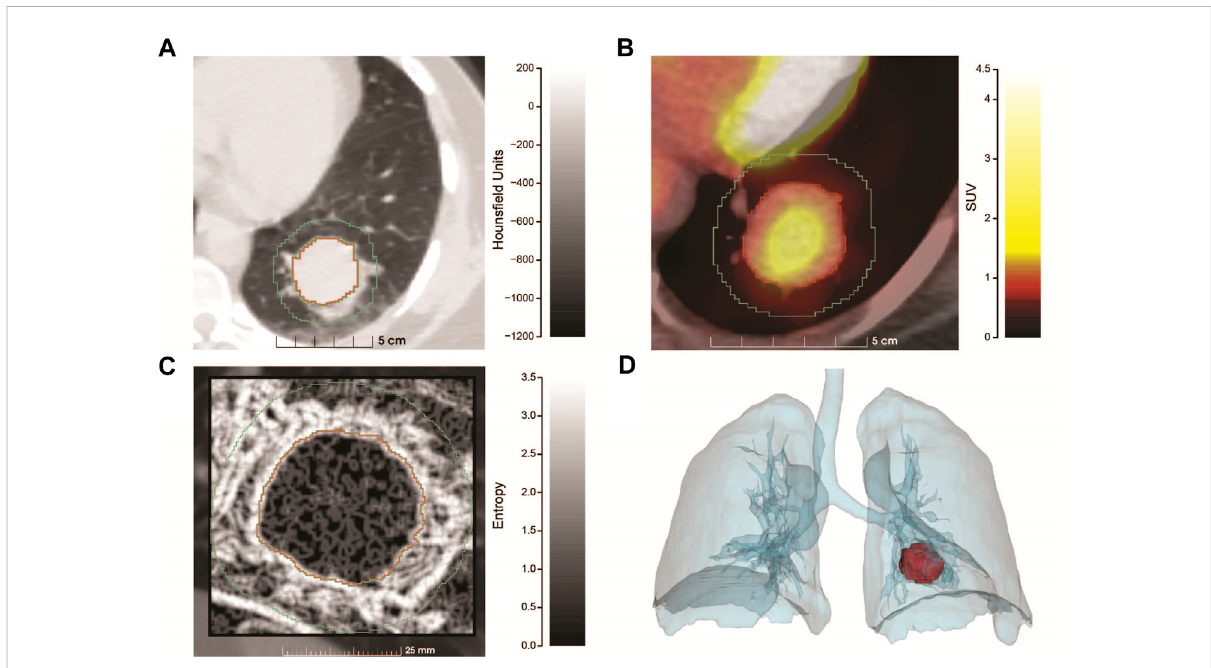
FIGURE 1 Radiomics analysis of the PSP tumor. (A) Pre-operative chest CT scan with contrast utilizing lung window settings. The image is an axial projection that has been zoomed to show an optimal view of the tumor that resides in the left lower lung along with a small region of the mediastinum. Tumor segmentation is outlined in red, with the 1 cm border surrounding the tumor proper, outlined in green. The x-axis contains a sizescale(cm)andy-axisHouns fi eldUnits(HU)scale( − 1200 – 200)withshading. (B) CombinedPET/CTofthetumor(zoomed)atdiagnosis.The tumorhadaSUVmaxof2.2andSUVmeanof1.3,thex-axiscontainsasizescale(cm)andy-axiscontainstheSUVscale(0 – 4.5)withcolorcoding. (C) Feature map showing the entropy of the tumor and 1 cm surrounding region, generated from a sagittal slice of the CT at presentation. The tumor is signi fi cantly morehomogenousthan thesurroundingregion.The x-axis contains asize scale (mm)and y-axiscontainsan entropyscale (0 – 3.5)with shading. (D) Volume rendering showing the size and position of the tumor at diagnosis. Produced using segmentations of the lungs and tumor from the PET/CT